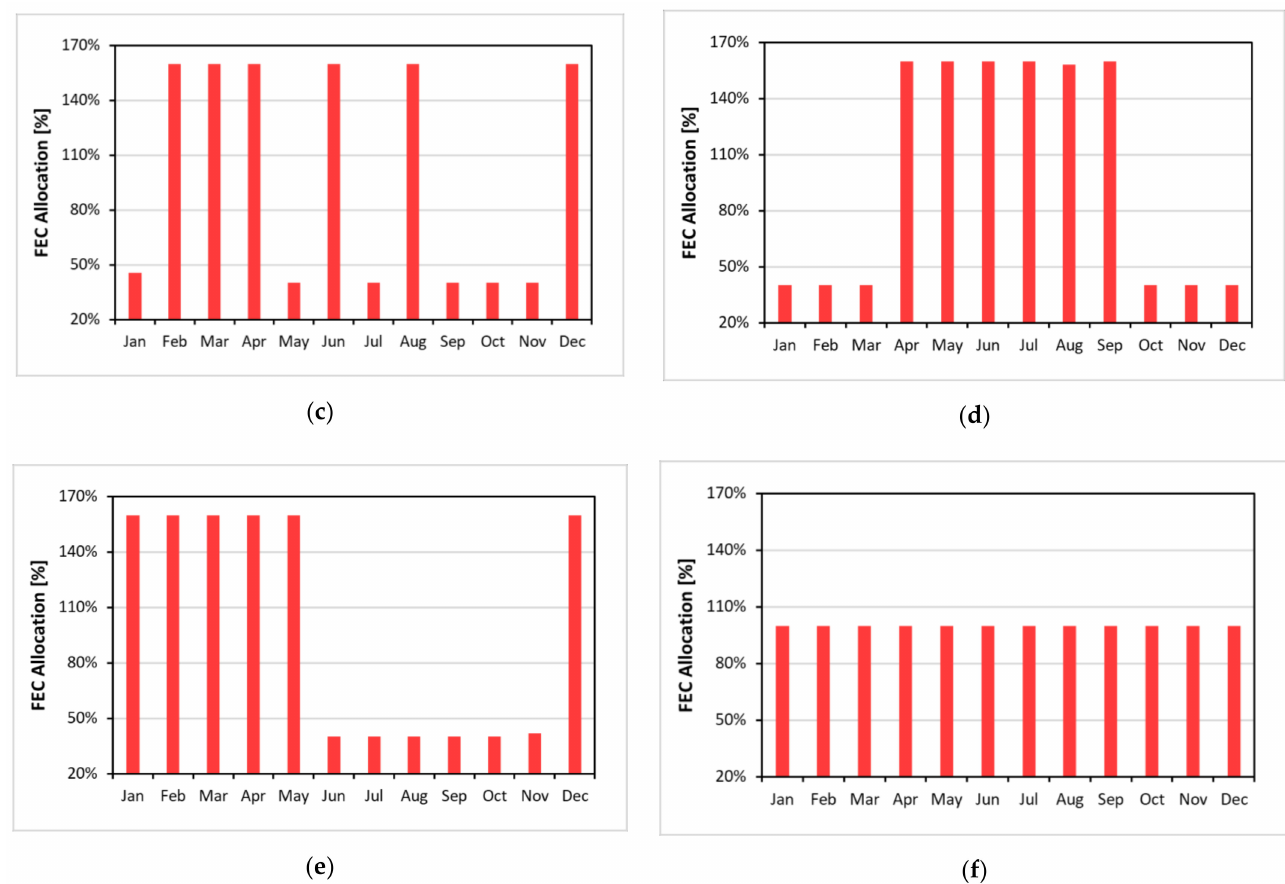
Figure 10. Player 2’s strategies: ( a ) CCEE GSF; ( b ) CCEE spot price; ( c ) NW spot price return; ( d ) NW spot price CVaR; ( e ) NW spot price × GSF return; and ( f ) Flat.